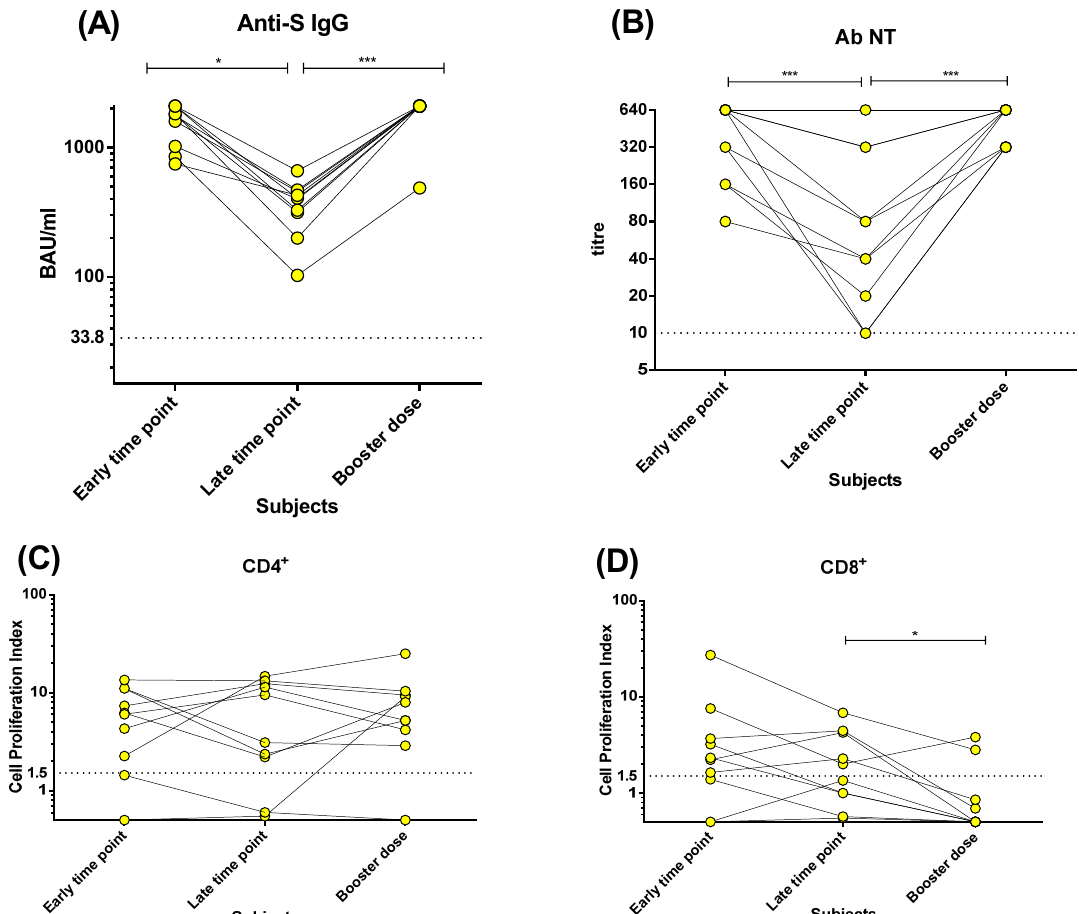
Figure 4. Spike (S)-specific antibody and T-cell responses were investigated in 10 vaccinated subjects receiving booster dose: ( A ) anti-S IgG; ( B ) neutralising antibodies (Nt Ab); ( C ) CD4 + T-cell proliferation index; ( D ) CD8 + T-cell proliferation index. Early time point: three weeks after two vaccine doses. Late time point: six months after two vaccine doses. Booster dose: three weeks after booster dose. * p < 0.05; *** p < 0.001.